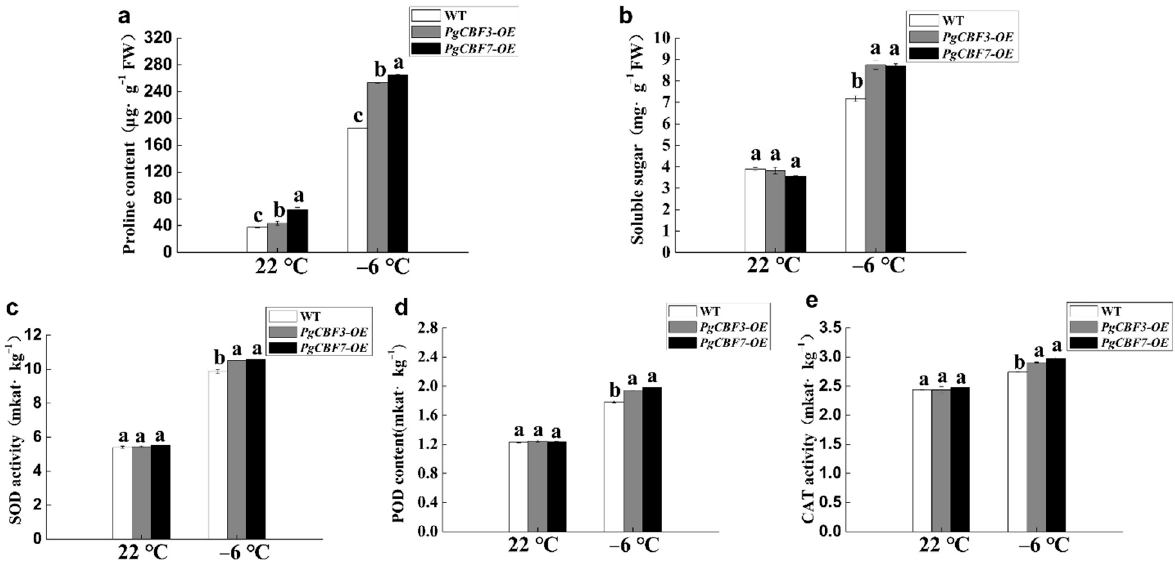
Figure 7. Proline ( a ), soluble sugars ( b ), and enzyme activity of SOD ( c ), POD ( d ), and CAT ( e ) in the PgCBF3 and PgCBF7 transgenic Arabidopsis at freezing temperature. Different letters present significant differences ( p < 0.05).